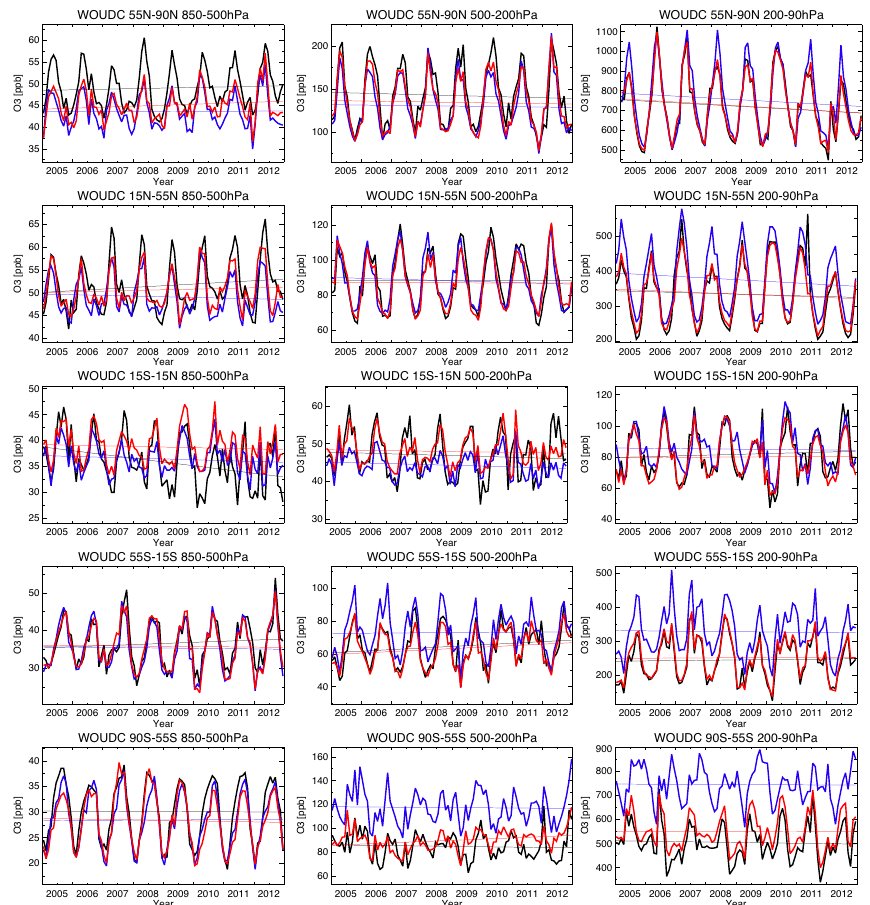
Figure 5. Time series of the monthly mean O 3 concentration obtained from ozonesondes (black), control run (blue), and reanalysis (red) averaged between 850 and 500hPa (left column), 500 and 200hPa (centre column), and 200 and 90hPa (right column). From top to bottom the results are shown for the NH high latitudes (55–90 ◦ N), NH mid-latitudes (15–55 ◦ N), tropics (15 ◦ S–15 ◦ N), SH mid-latitudes (15– 55 ◦ S), and SH high latitudes (55–90 ◦